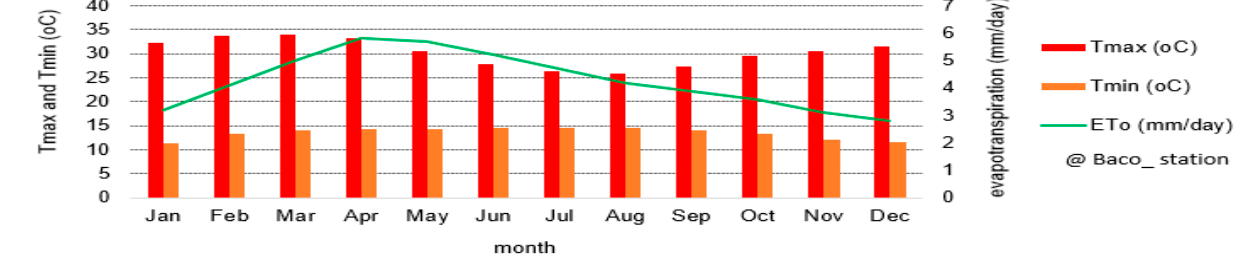
Figure 10. Average maximum and minimum temperature and evapotranspiration at Baco weather station (1998–2017).